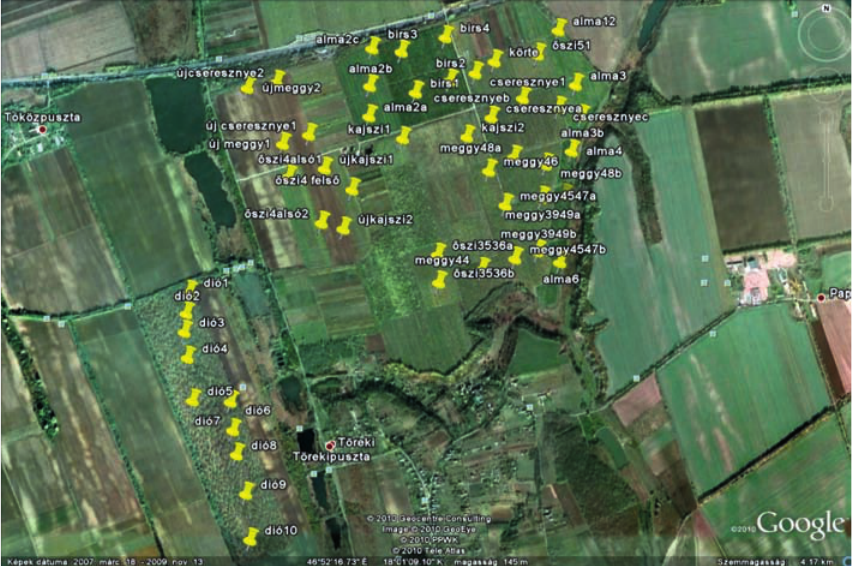
Figure 1 . Soil sampling points at the orchard Table 1. Technical information of ASIA DUAL hyperspectral